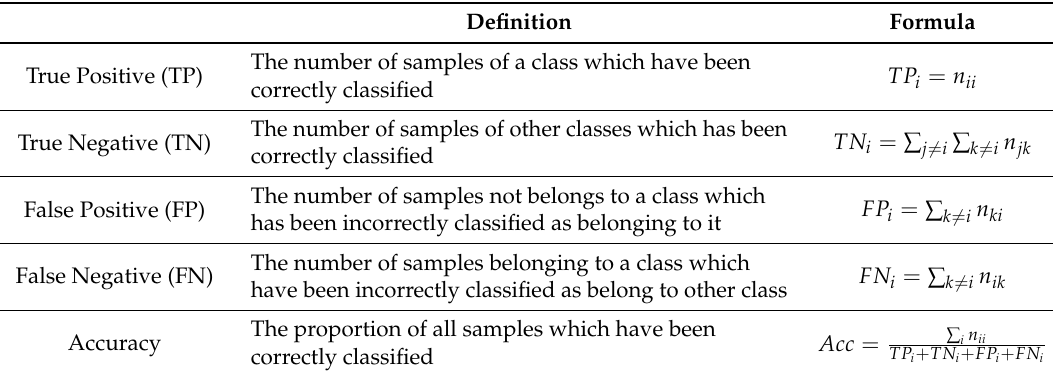
Table 3. Template of a confusion matrix for a 3-class